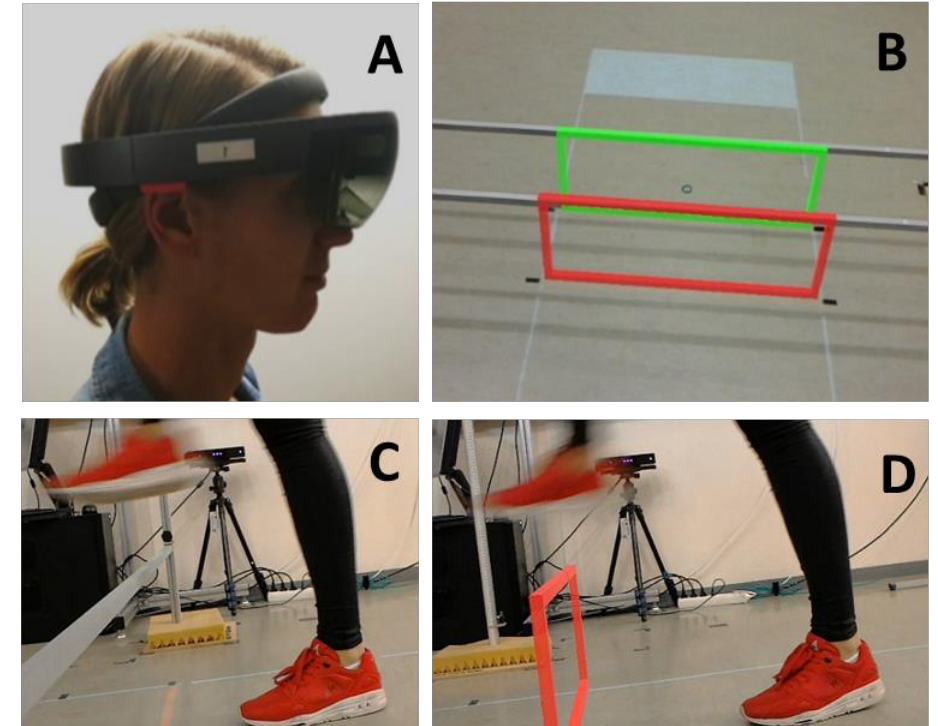
Figure 2. Person wearing a HoloLens mixed-reality headset ( A ), through which digital holographic obstacles can be merged with real physical obstacles of similar height and depth ( B ); all participants reported visual overlap). Examples of avoiding real ( C ) and holographic ( D ) obstacles (both 0.30 × 0.02 m).